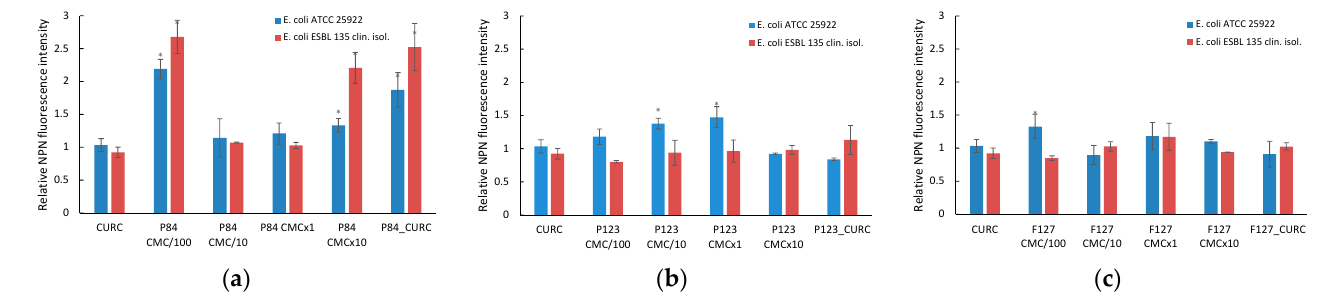
Figure 10. Relative NPN fluorescence in E. coli cultures incubated with micellar and unassociated molecules of Pluronic derivatives: Pluronic P84 ( a ); Pluronic P123 ( b ); Pluronic F127 ( c ). The concentration of Curcumin solubilized in DMSO and in polymeric micellar dispersion is 100 μ M. Concentrations of Pluronic derivatives were selected according to their CMC values (Table 1) to cover the micellar domain (concentrations equal to CMC and 10-fold higher) and unimer domain (concentrations equal to CMC/100 and CMC/10).